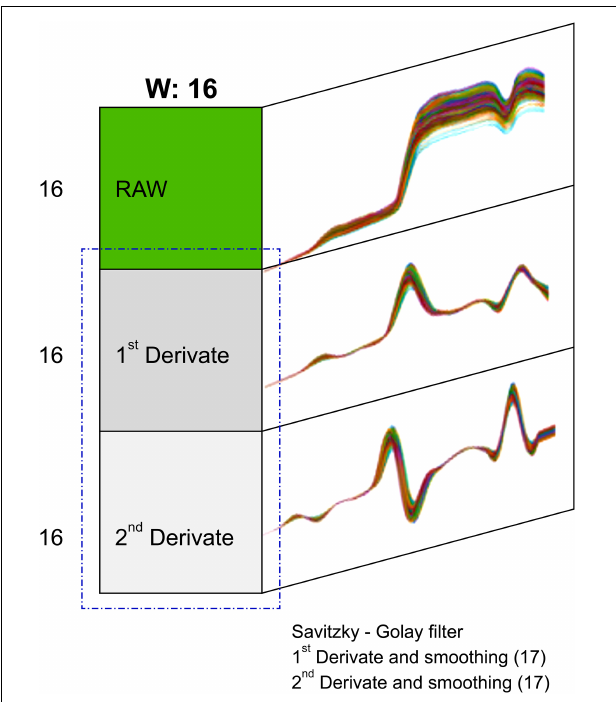
FIGURE 9 | 3D input layer structure expanded by a Savitzky–Golay filter.